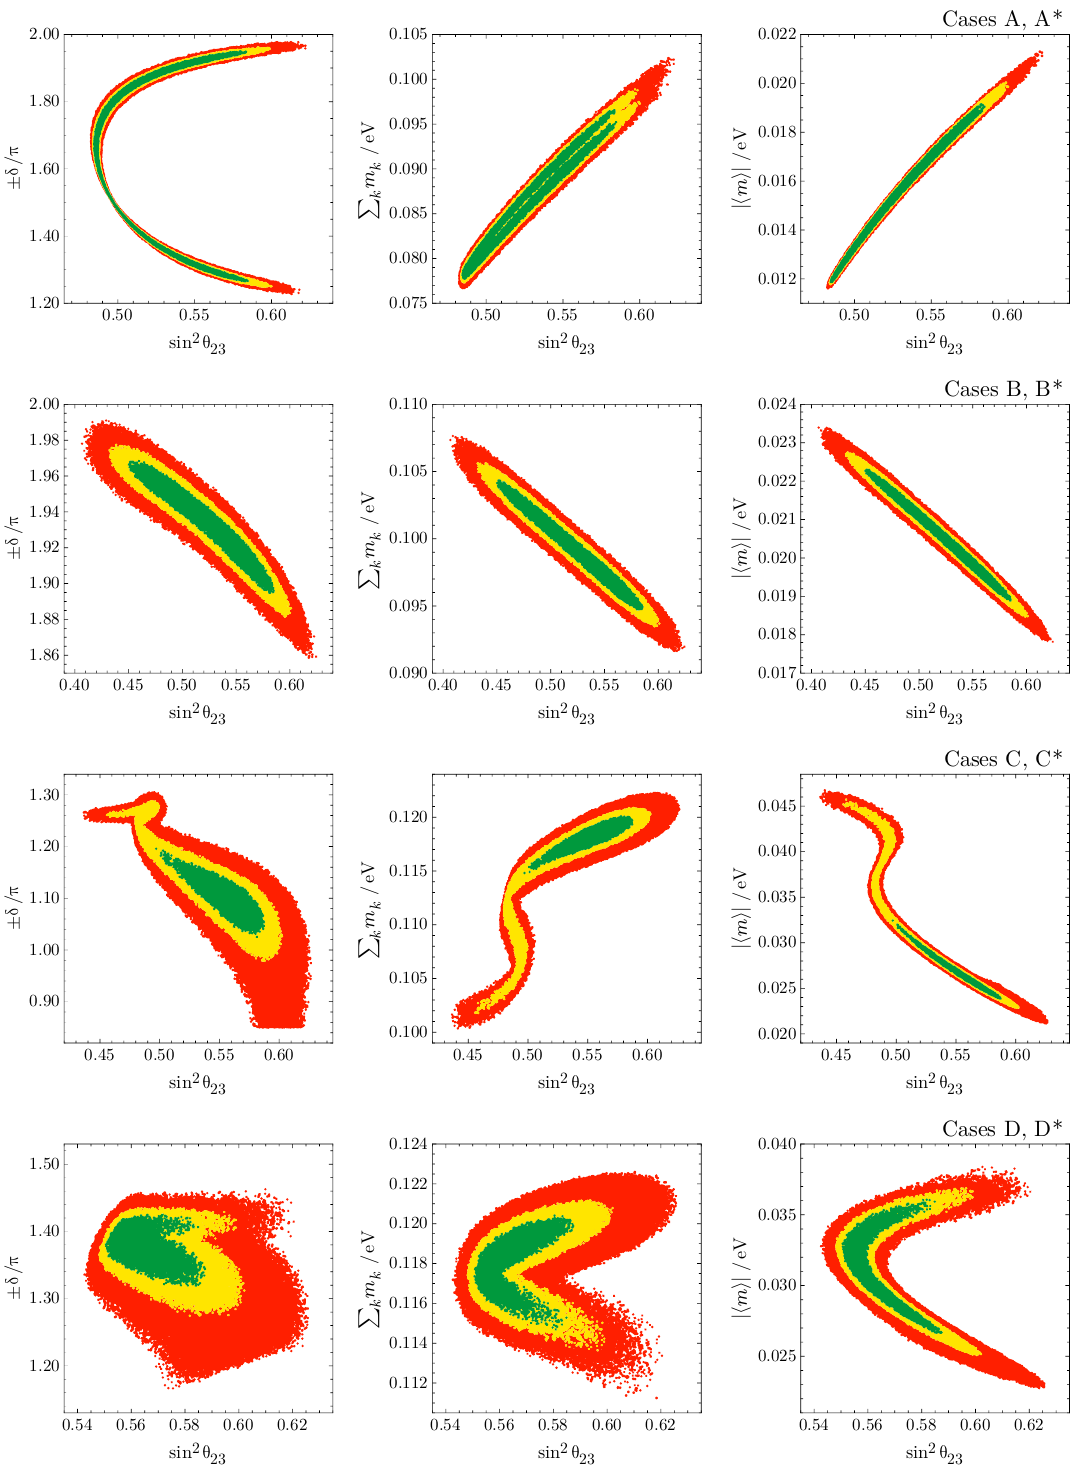
Figure 2. Correlations between sin 2 (cid:18) 23 and the Dirac CPV phase, the sum of neutrino masses, and the e(cid:11)ective Majorana mass in neutrinoless double beta decay, in models with ( k (cid:3) ; k g ) = (0 ; 2). The plus (minus) sign of (cid:14) refers to the case without (with) an asterisk.